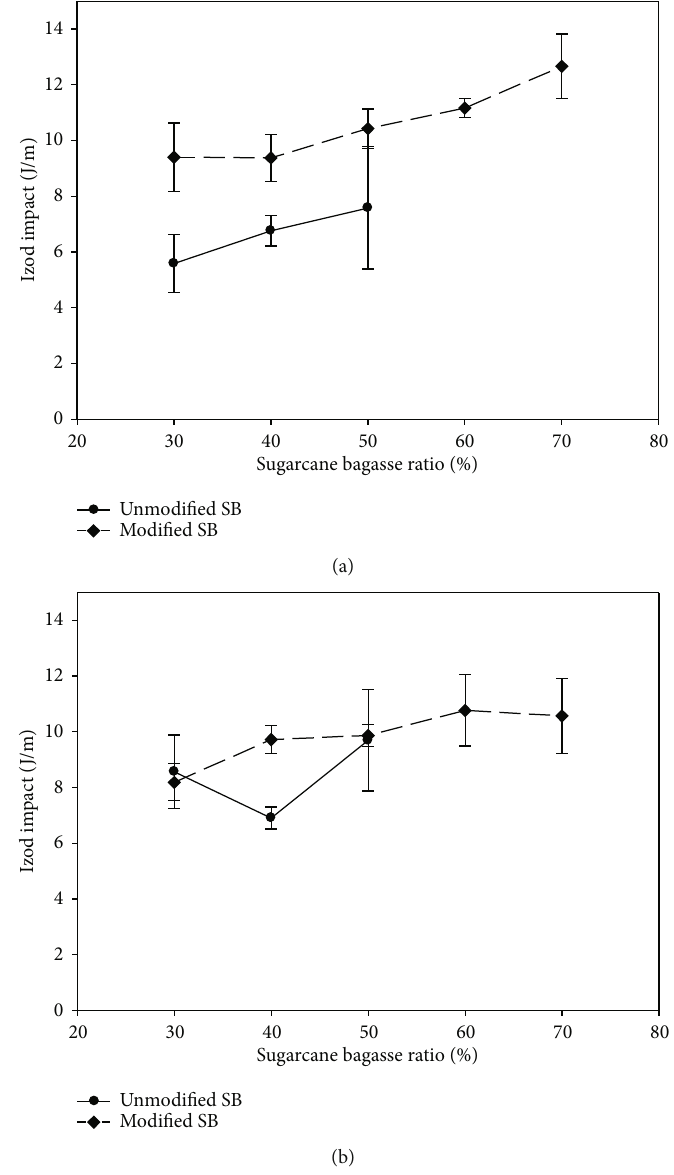
Figure 13: Izod impact strength of PPG 700 elastomer and PPG 1000